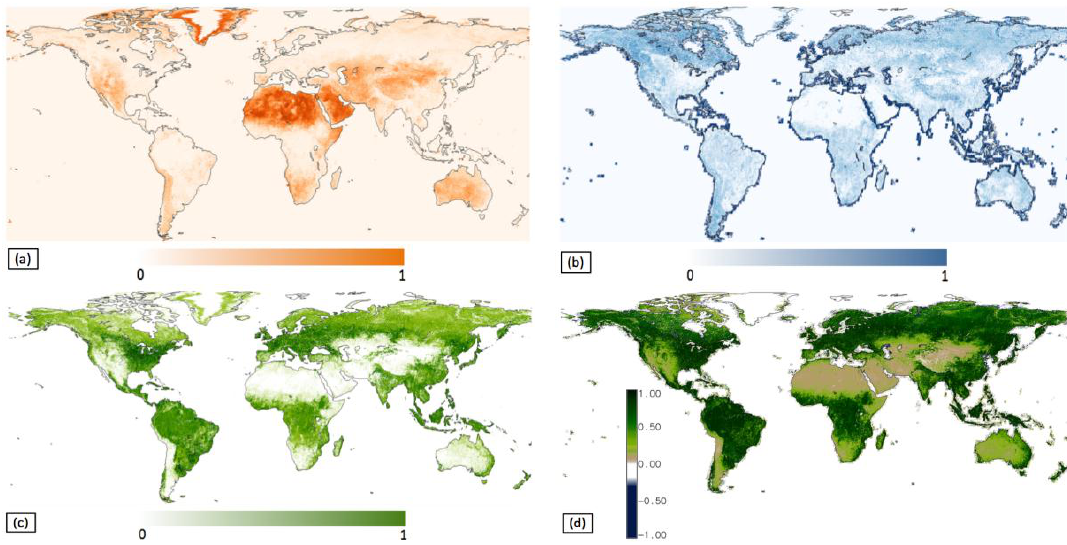
Figure 6. Global abundance maps of ( a ) substrate, ( b ) dark objects, ( c ) vegetation and ( d ) NDVI— Normalized Difference Vegetation Index obtained from the 2011 annual WELD.